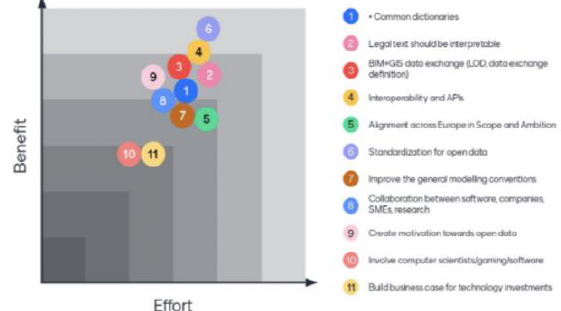
Figure 3. Effort-Benefit of Requirements for